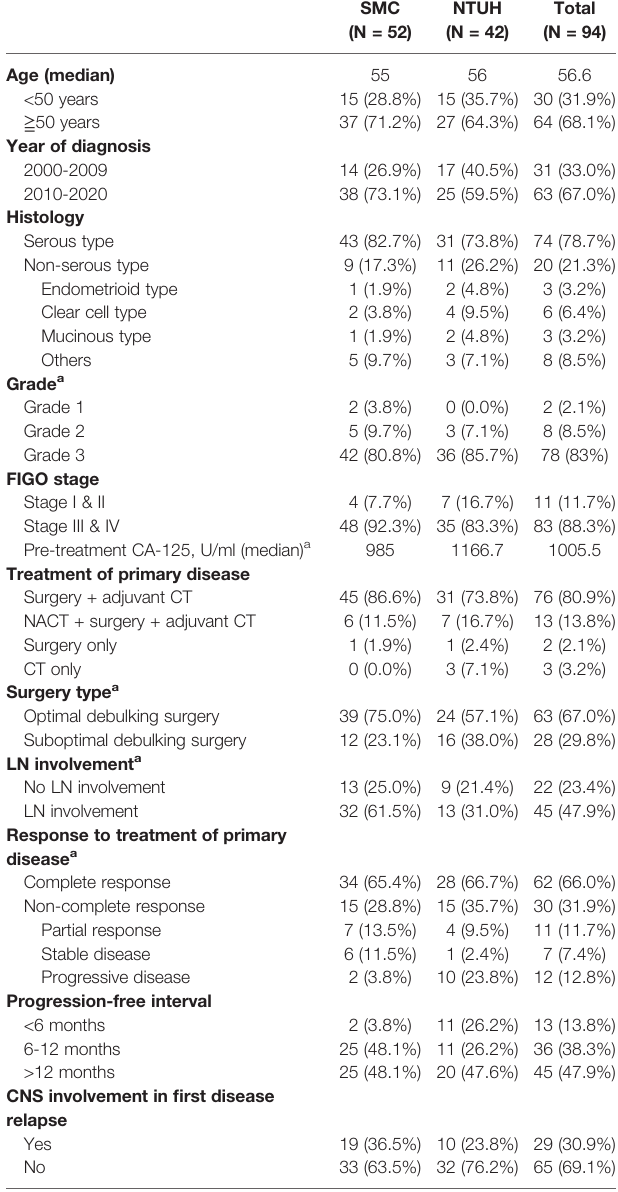
TABLE 1 | Basic characteristics of this studied population from SMC and